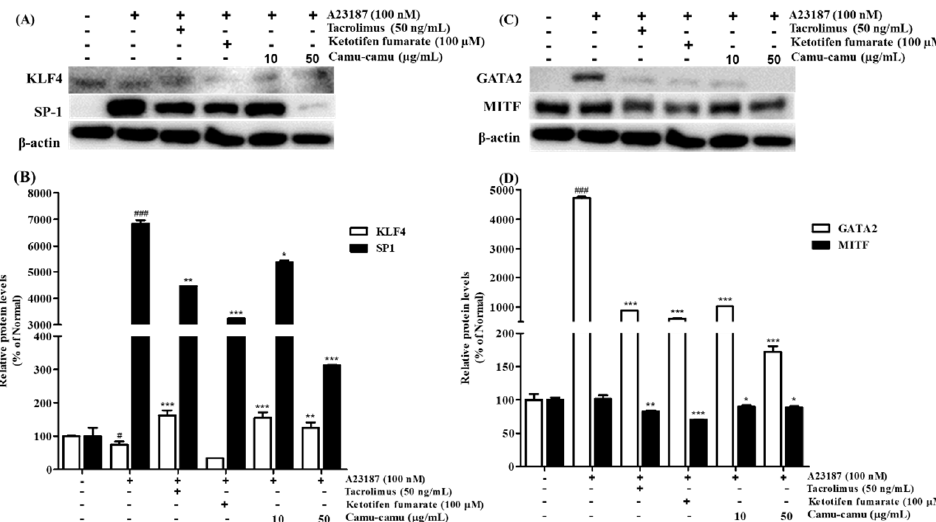
Figure 8. Effect of camu-camu fruit extract on KLF4/SP1 ( A , B ) and GATA2/MITF ( C , D ) expression in A23187-induced RBL-2H3 cells. Band intensities of KLF4, SP1, GATA2, and MITF were quantified by densitometry, normalized to the level of β -actin. Then, it was calculated as a percentage of non- treated cells and displayed as mean ± SD of three independent experiments ( # p < 0.05 and ### p < 0.001 vs. the control group, * p < 0.05, ** p < 0.001 and *** p < 0.001 vs. the A23187-treated group).